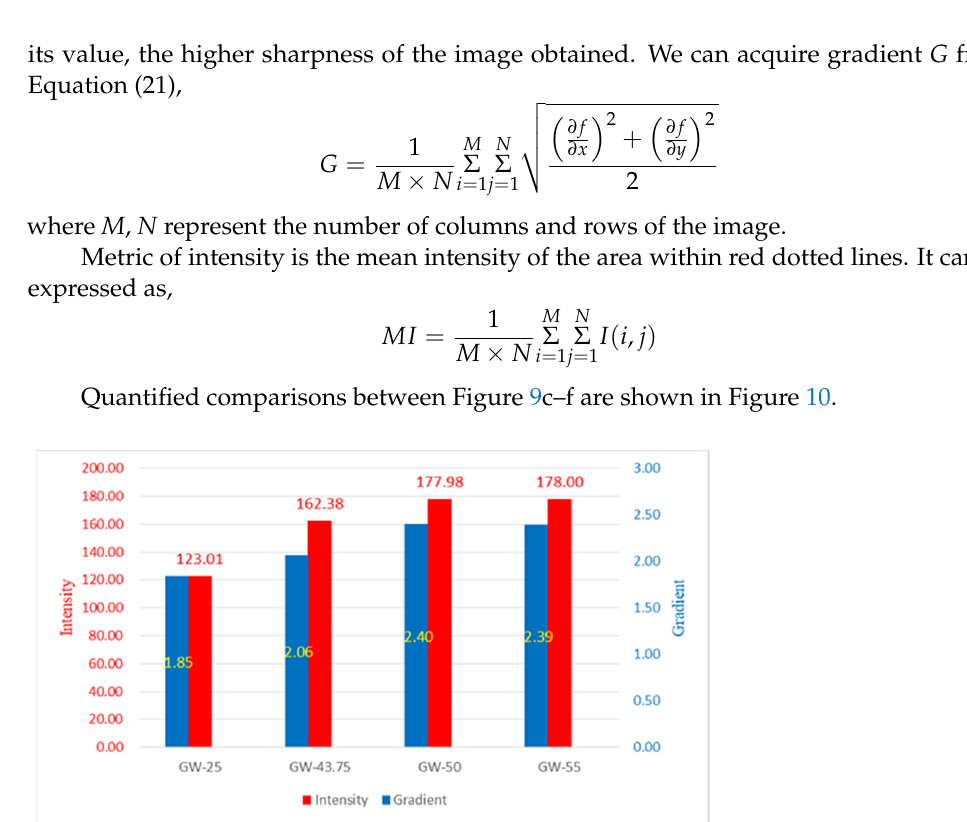
( f ) Figure 9. Performance of single slice and multi-slice. ( a ) Two targets in experiment; ( b ) Output of single slice; ( c ) Output of multi-slice, whose GW is 25 ns; ( d ) Output of multi-slice, whose GW is 43.75 ns; ( e ) Output of multi-slice, whose GW is 50 ns; ( f ) Output of multi-slice, whose GW is 55 ns. Output of single slice shows that target 2 is much darker than that of target 1 because light decays rapidly underwater with increasing distance. Output of MSI method are much better than single slice. Furthermore, in all three MSI method, GW of 50 ns is the best.